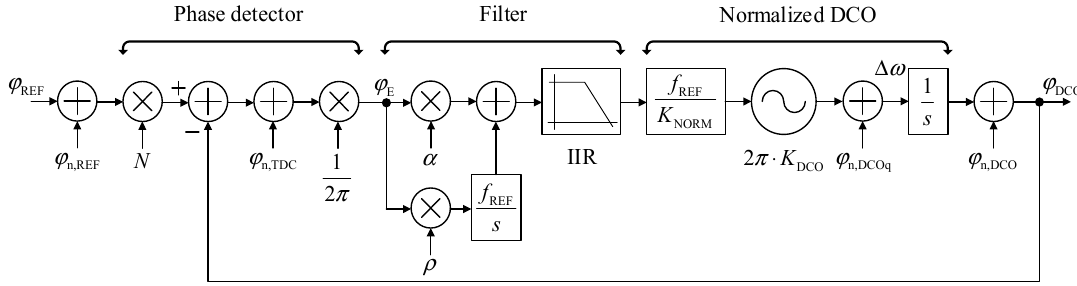
Figure 1. s -domain model of a higher order type-II all digital frequency synthesiser with noise sources.